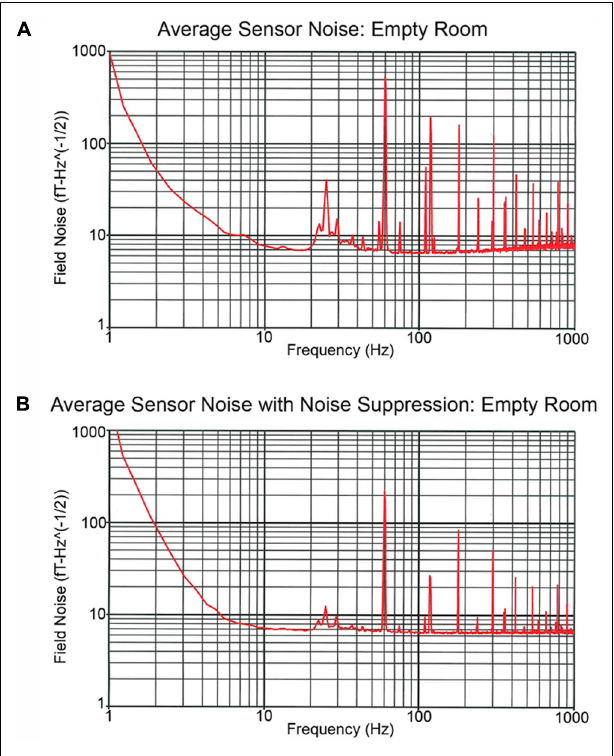
FIGURE 3 | Recordings obtained in the empty MSR. (A,B) show the spectra averaged across all sensor channels.The (A) power spectrum shows several large peaks below 100 Hz.These include the 60 Hz powerline peak as well as a peak at ∼ 24 Hz which reflects noise from the local mass transport/train system. In (B) , the reference channels were used to remove external noise, the weights obtained by calculating the covariance between signal and reference channels and then the weights applied to the raw data with no temporal filtering. (B) shows that via spatial filtering most of the noise activity below 100 Hz is